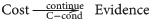
Computational modeling of sampling choices and decision times.(a) Schematic of one-stage and two-stage models. One-stage models only consist of the steps on the left-hand side: Each time a participant decides whether to stop or continue sampling, the probability of stopping is a sigmoid function of a linear combination of multiple decision variables. Two-stage models assume that participants may probabilistically have a second thought to reconsider the choice (the coral dashed arrow). The second stage (on the right-hand side) works in the same way as the first stage but the two stages are controlled by different sets of decision variables. (b) Results of model comparison based on the joint fitting of choice and DT. The ΔAICc for a specific model was calculated for each participant with respect to the participant’s best-fitting model (i.e. lowest-AICc) and then summed across participants. Both fixed-effects (summed ΔAICc: lower is better) and random-effects (estimated model frequency: higher is better) comparisons revealed that the best-fitting model was a two-stage model with cost-related variables considered in the first stage and evidence-related variables in the second stage (i.e. Cost→C–condcontinueEvidence). The best one-stage model was the model involving only cost-related decision variables (i.e. Cost only). See Methods (or S1 Table) for the description of each model. Estimated model frequency (color coded) is a random effects measure of the proportion of participants best fit by the model. (c) Distribution of sample sizes (i.e. number of bead samples) for each condition: data vs. model predictions. (d) Distribution of DTs for each condition: data vs. model predictions. The best-fitted two-stage model (red curves) well predicted the observed distributions (histograms) of sample sizes and DTs for each cost and evidence condition, including the bimodality of the observed DT distributions, while the best-fitted one-stage model (blue curves) failed to do so. Both data and model predictions were aggregated across participants.